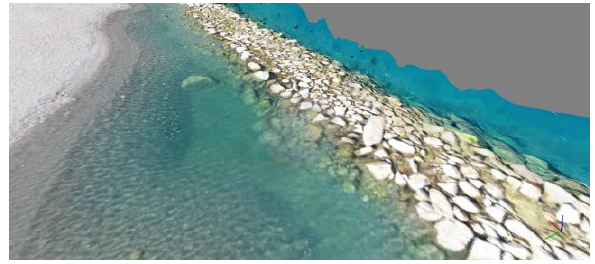
Figure 3. Barrier 3D from UAV survey